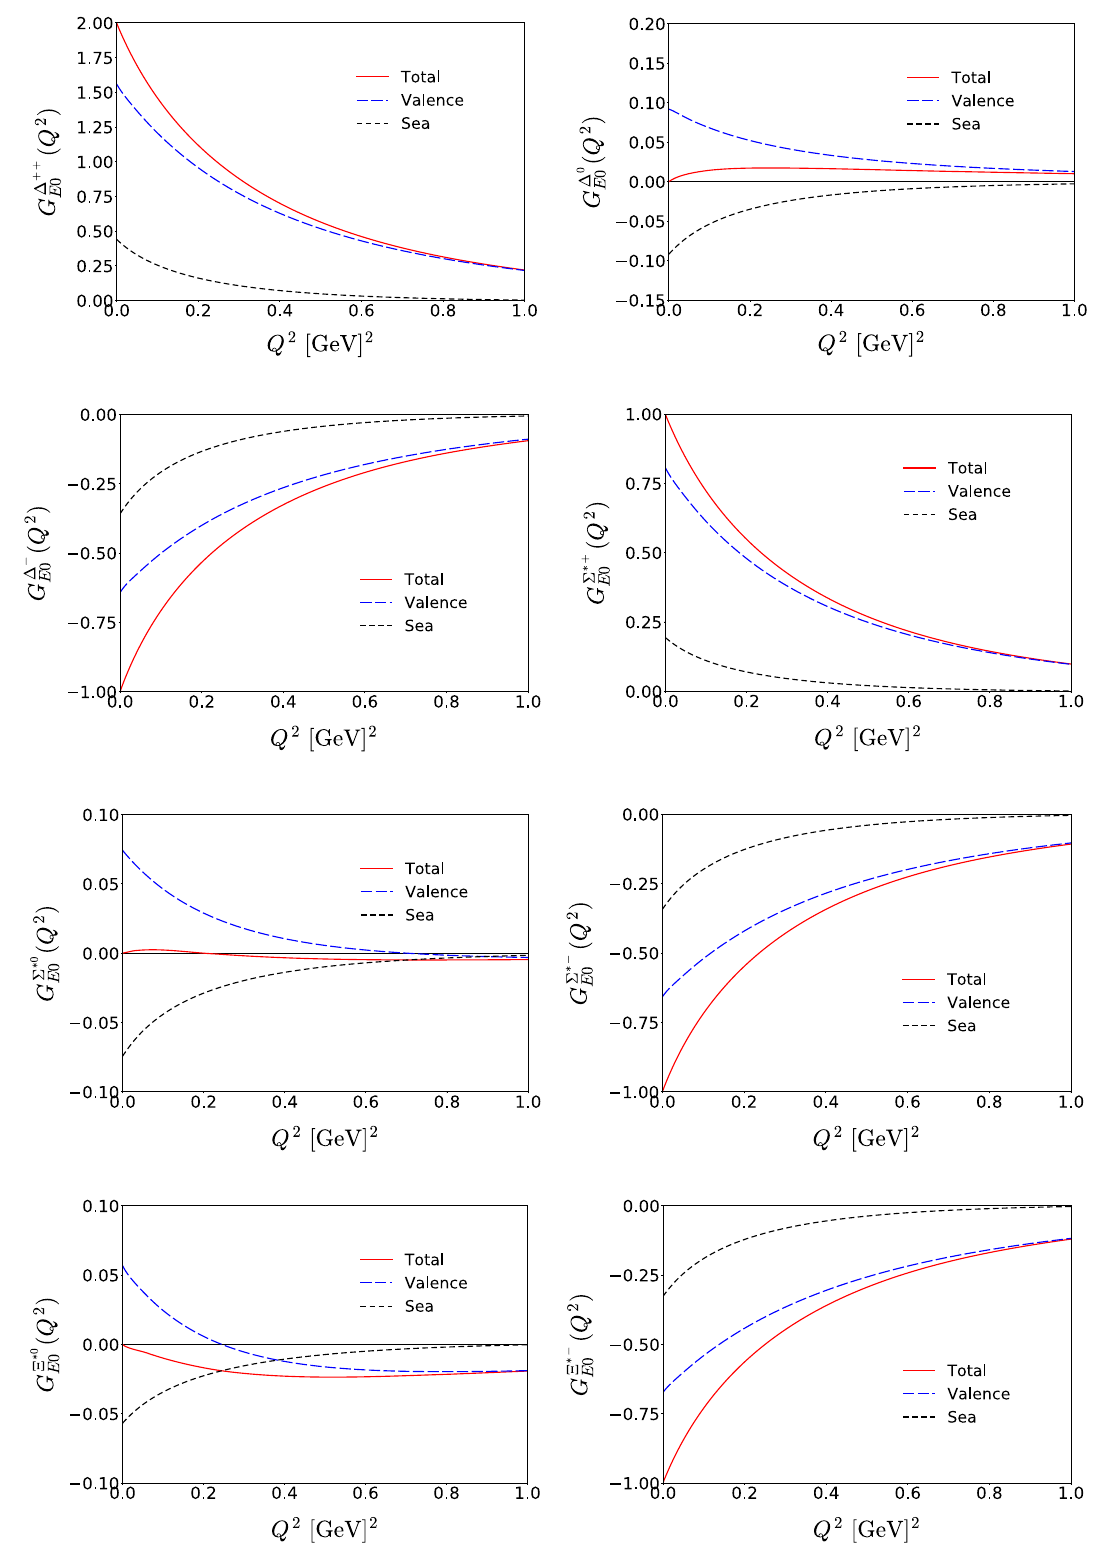
Fig. 2 Sea and valence contributions of the electric monopole form factors of the other members of the baryon decuplet except for the (cid:2) + and (cid:5) − baryons. Notations are the same as in Fig.